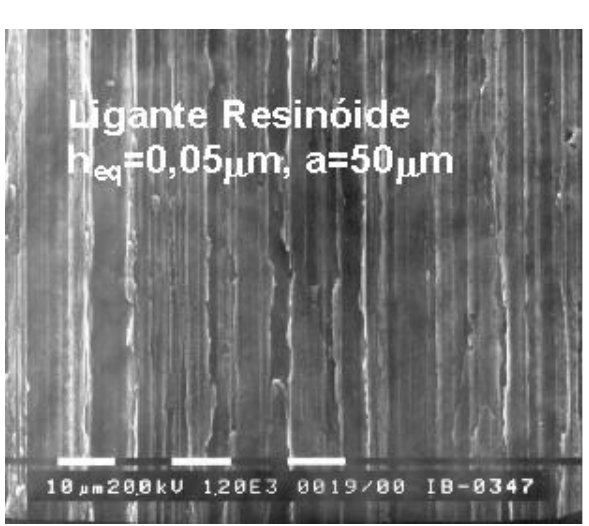
Figura 5. Ensaio 5.